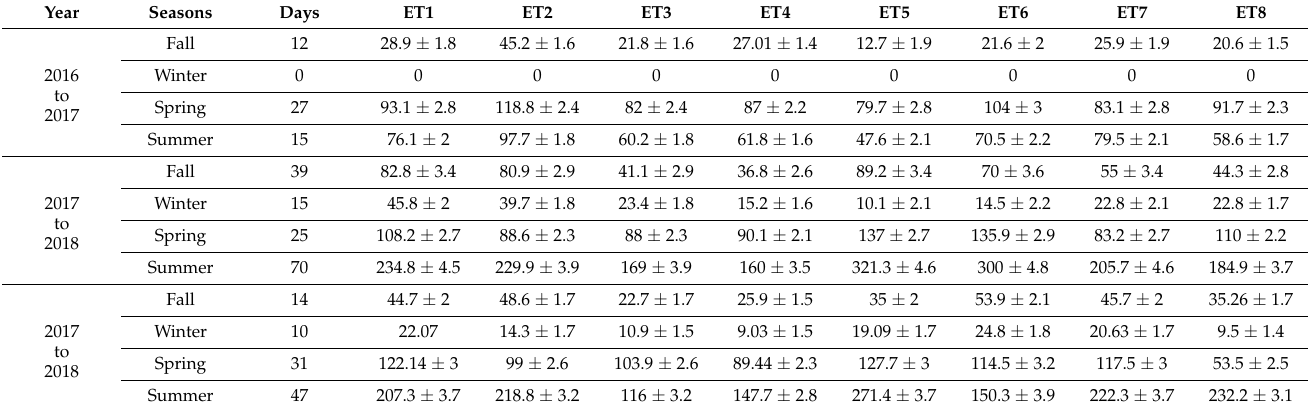
Table A4. Cumulative ET in mm for the lysimeters in common validated days (305/1098).